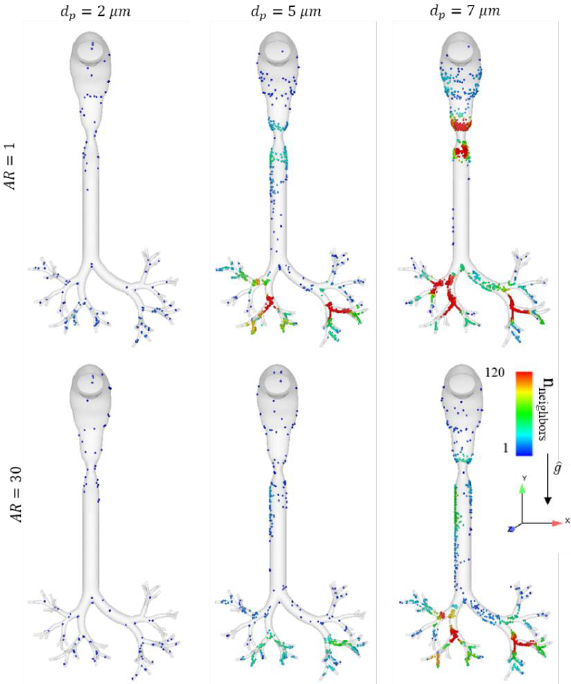
Figure 2. Deposition maps for fibers with selected aspect ratios ( AR ; rows) and equivalent diameters (columns) at the end of the DPI maneuver ( t = 3 s) in the upper airway domain. The particle deposition is color coded according to the number of neighbors within a 10 mm radius. It is clear that fibers of equivalnt diameter ( d p ) > 2 mm deposit less and disperse more compared to spheres. We note that 7 µm particles are strongly influenced by impaction, causing them to be deposited in the characteristic “hot spots” of the domain, although elongation (i.e., the AR ) qualitatively increases dispersion outcomes.